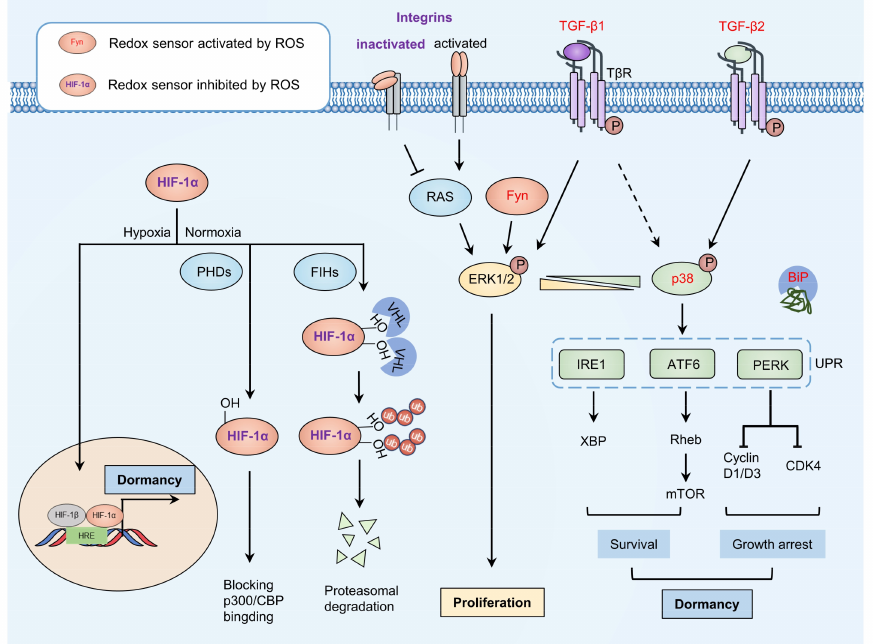
Figure 2. Model of dormancy entrance. The balance between proliferation and dormancy may be partly dependent on the ratio of p-p38 and p-ERK1/2. Redox can activate TGF- β 2 and inactivate integrins to activate p38 and inhibit activation of ERK1/2, as well as to modify ER chaperone BiP for release from key regulators of ER-stress signaling, thus activating ER-stress signaling and promoting cell survival and growth arrest. Redox-activated TGF- β 1 and Fyn can activate ERK1/2 to promote cell proliferation, while integrins activate when it is not redox-modified. HIF-1 α is inhibited under normoxia through redox modification mediated by PHDs and FIHs. Under hypoxia conditions, HIF-1 α may translocate to the nucleus and promote transcription of dormant-related genes. ER, endoplasmic reticulum; ERK1/2, extracellular signal-regulated kinase 1/2; FIHs, factor inhibiting HIF-1; HIF-1 α , hypoxia-inducible transcription factors 1 α ; TGF- β 2, transforming growth factor β